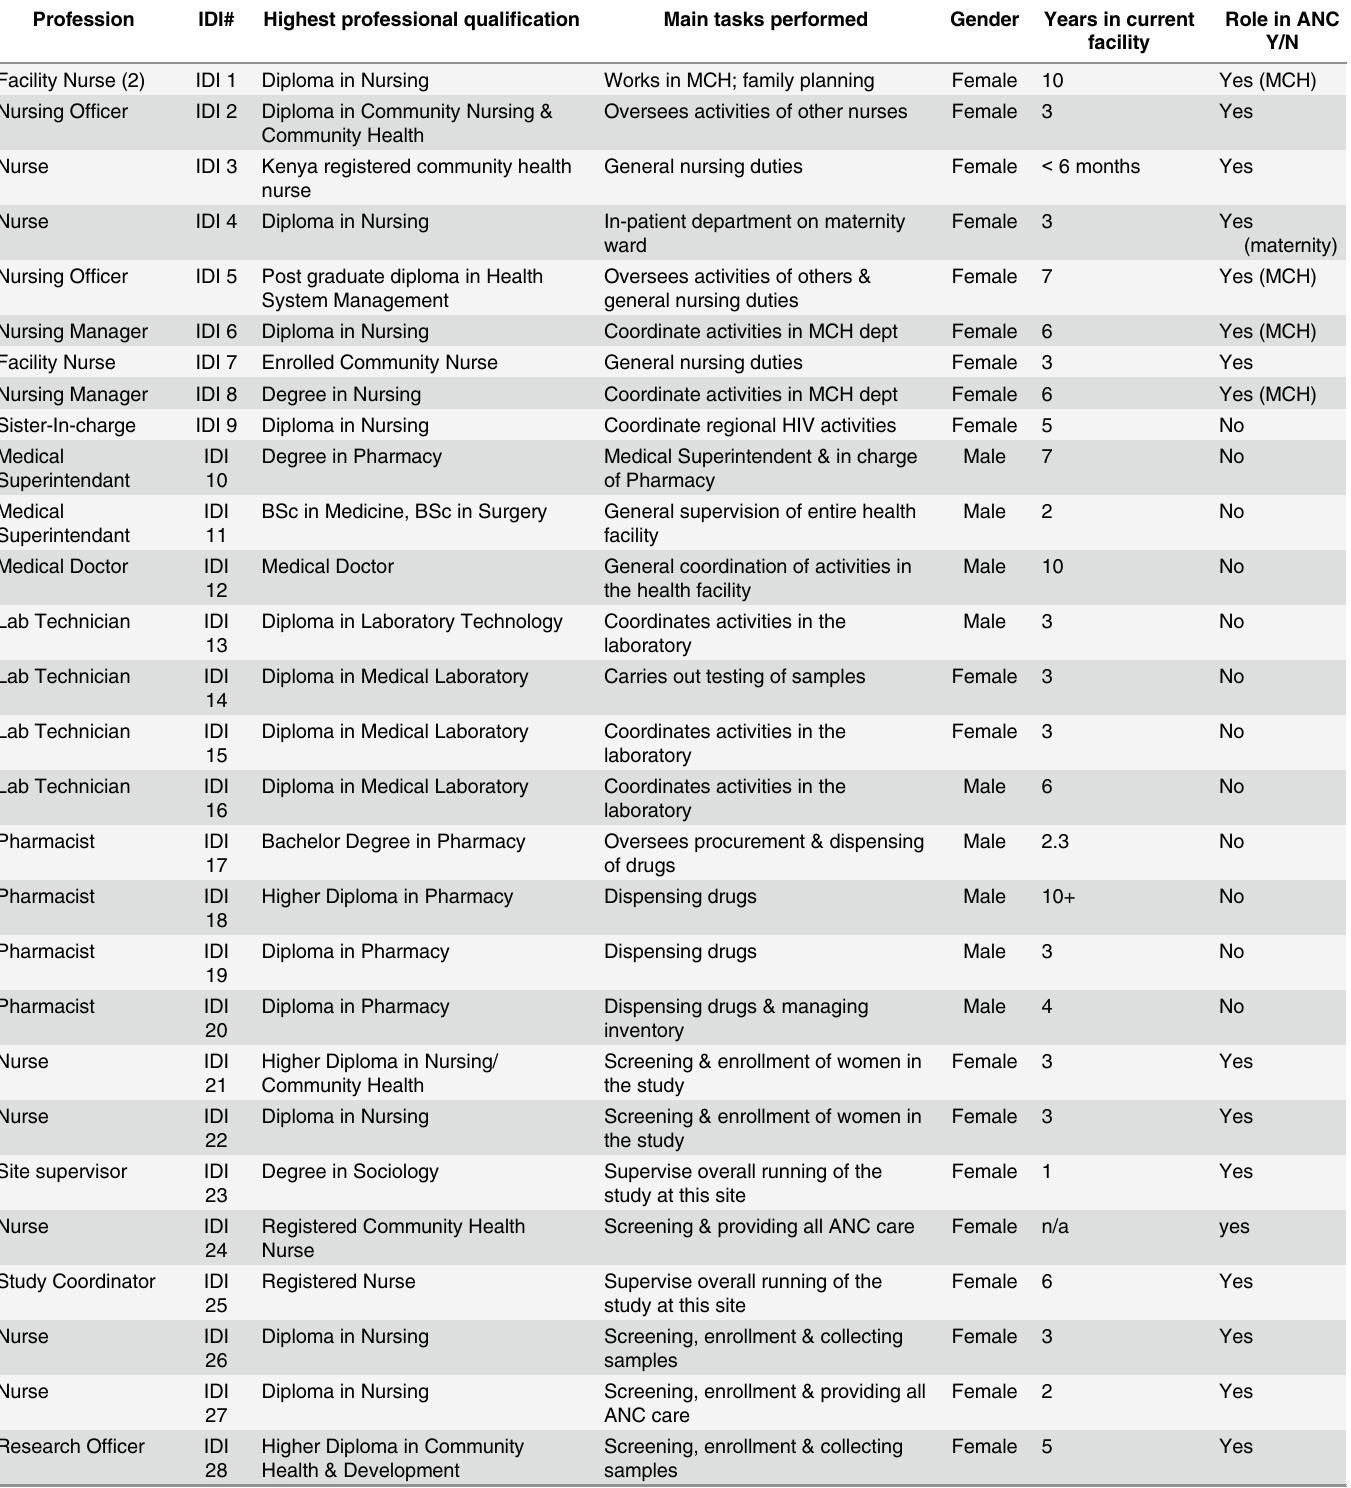
Table 3. Health provider and trial staff